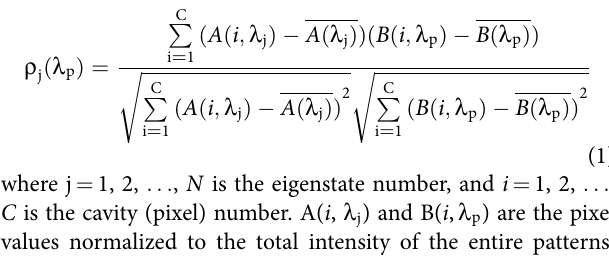
characterizing an imperfect eight-microring CROW, including the inhomogeneously broadened transmission bands upon a buffer solution ( n 0 ) and a test solution ( n 0 + ∆ n ), and pixelized mode-field-intensity distributions at eigenstate wavelength λ j upon n 0 , A( λ j ). Insets: pixelized mode-field-intensity distributions at probe wavelength, λ p , (i) upon n 0 [B( λ p )]; and (ii) upon n 0 + ∆ n [T( λ p